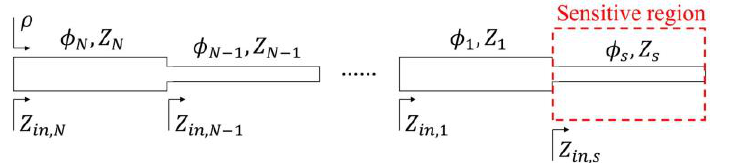
Figure 8. Schematic of the reflective-mode phase-variation sensor based on an open-ended sensing line cascaded to a step-impedance transmission line structure. Reprinted with permission from [62].